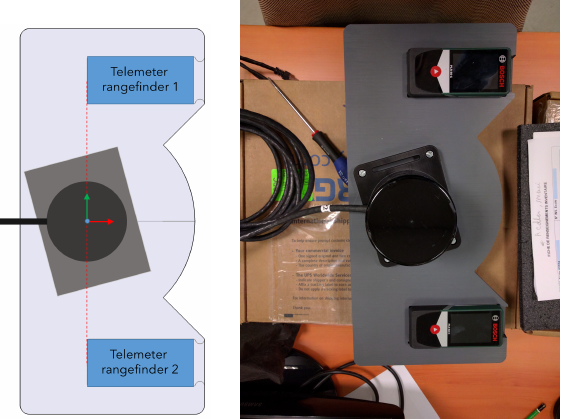
Figure 8: Fixation made for